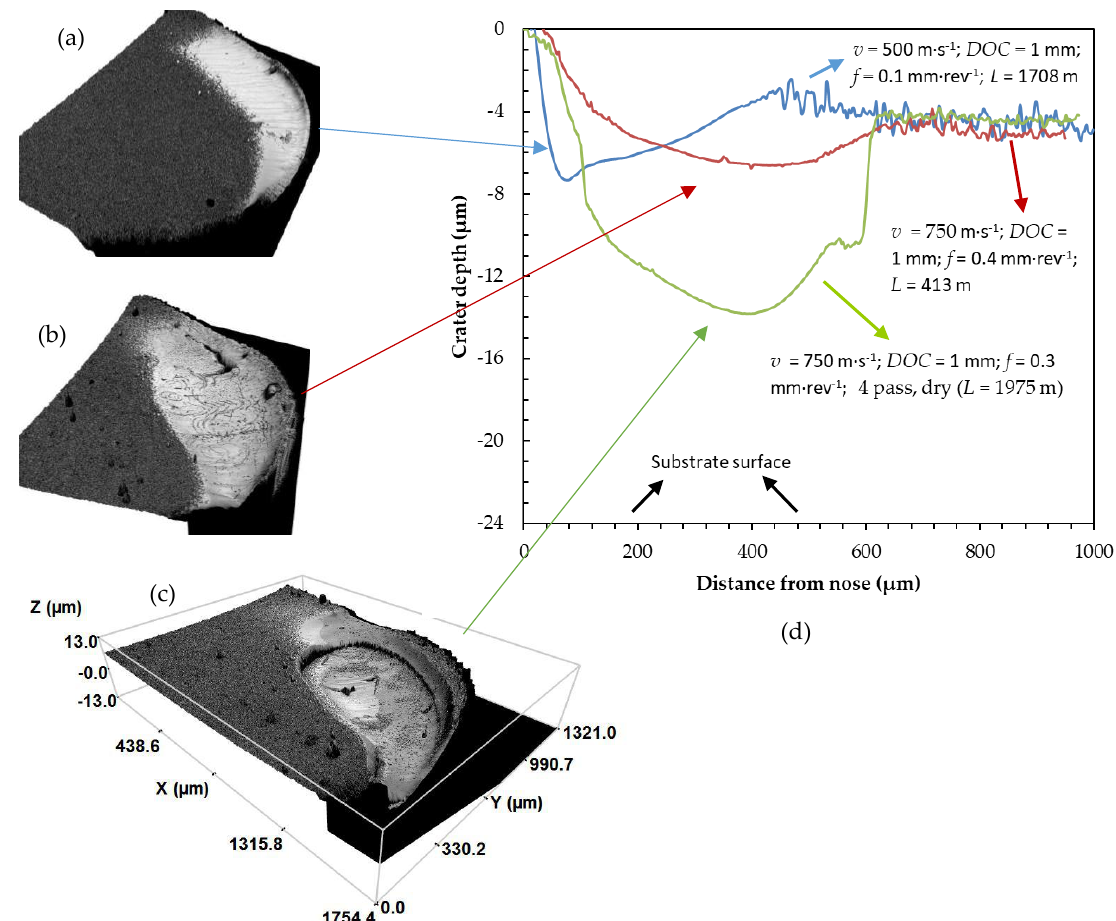
Figure 6. ( a – c ) Stacked image obtained by optical profilometry of the rake face near the nose of the inserts after machining under different turning conditions; ( d ) Graphic with depth profiles across the wear crater, from the nose of the tool towards the centre of the triangular inserts.